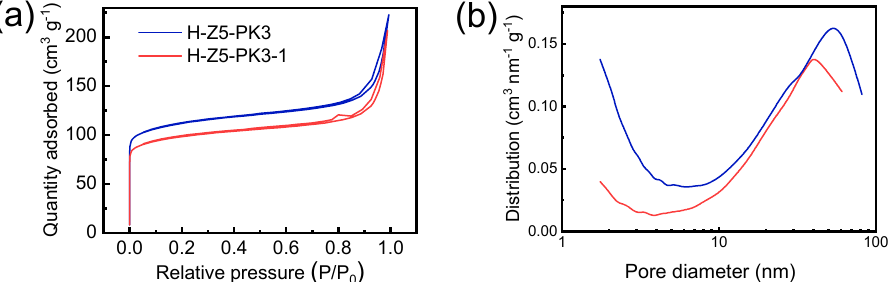
Figure 4. ( a ) Ar adsorption–desorption isotherms and ( b ) BJH pore–size distribution curves of H-Z5-PK3 and H-Z5-PK3-1.